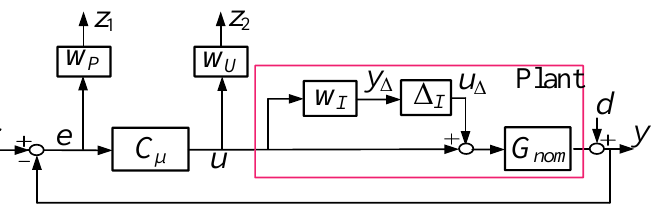
Figure 8. Description of a system with multiplicative uncertainty representation.